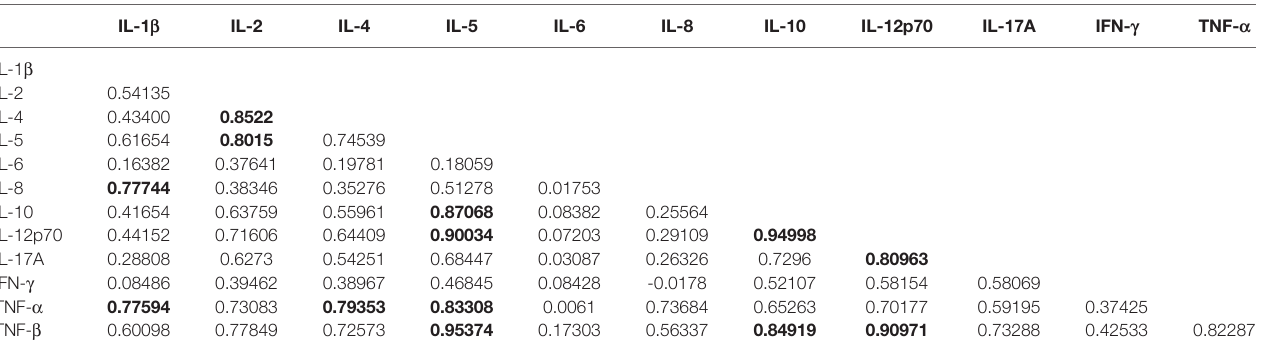
TABLE 6 | Correlation matrix of 12 cytokines in normalised